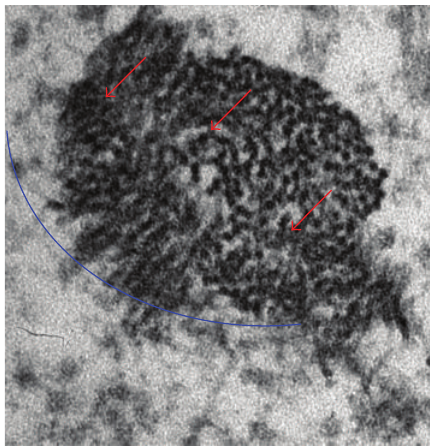
Figure 4: TEM images of AgNps (red arrows) in cytoplasmatic spaceoffibroblastpresentinahealedskinsampletreatedwithAgNP based medical devices.